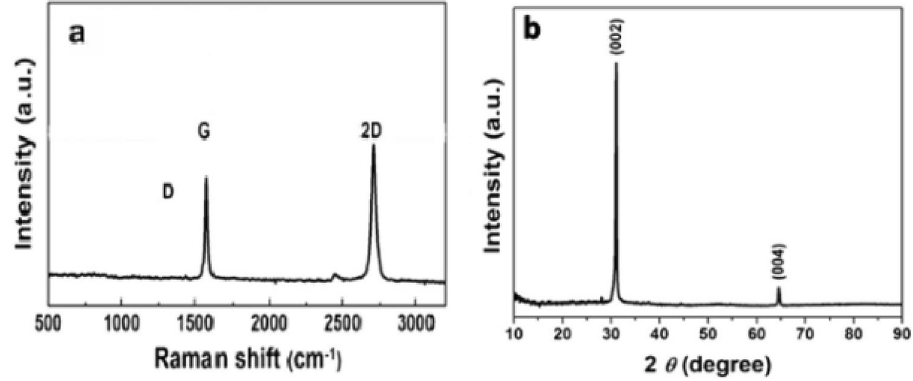
Fig. 1 a Raman, and b XRD patterns of the as-synthesized GF sample,